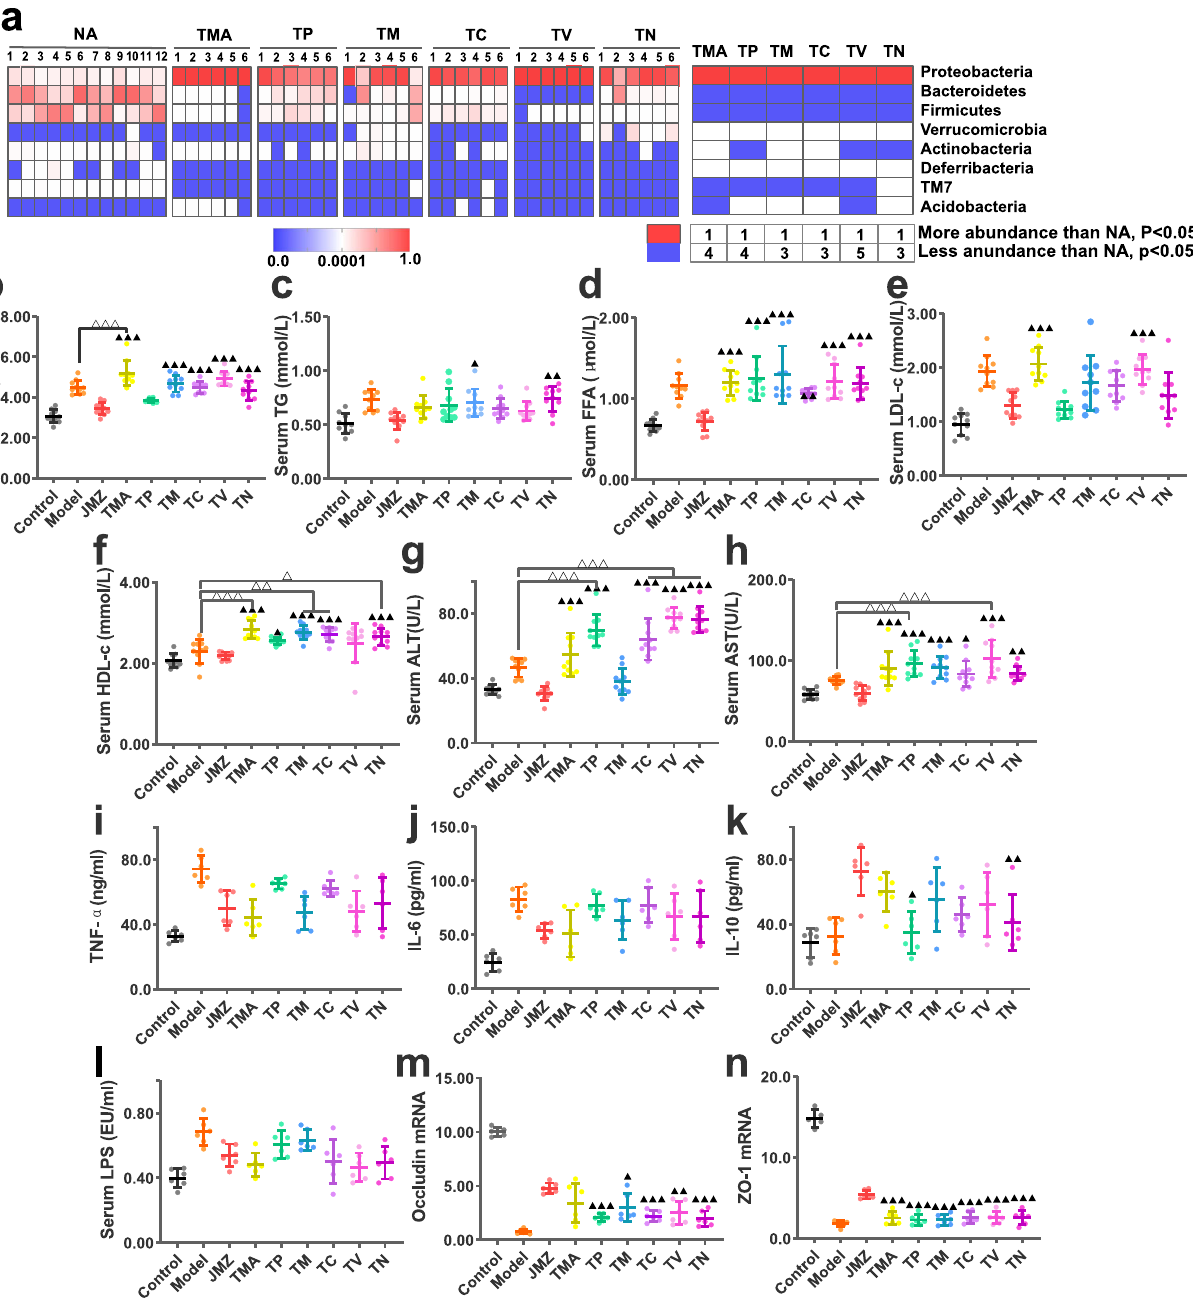
Fig. 4 Extracts or compounds administration ameliorate antibiotic-induced dysbiosis in HFD-fed mice. Phylum changes before and after antibiotic administration which before CSE administration ( n = 6 each/group) ( a ). CS ef fi cacy toward NAFLD was weakened or eliminated after HFD-fed mice gut microbiota was disturbed by antibiotics. Serum TC ( b ), TG ( c ), FFA ( d ), LDL-c ( e ), and HDL-c ( f ) levels. Serum ALT ( g ), serum AST ( h ) levels. Data are presented as the mean ± SD ( n = 10 mice/group). TNF- α ( i ), IL-6 ( j ), IL-10 ( k ), and serum LPS ( l ) levels. The relative expression of occludin ( m ), ZO-1 ( n ) mRNA, n = 6 mice/group. Data are presented as the mean ± SD. Statistical analyses were performed using Tukey ’ s multiple comparison test. ▲ P < 0.05, ▲▲ P < 0.01, ▲▲▲ P < 0.001 vs. CSE group. *** P <